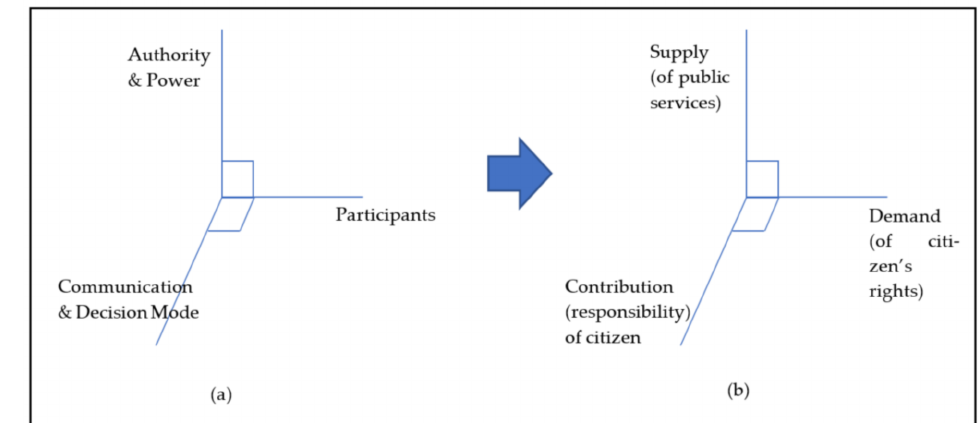
Figure 3. From democracy cube to co-created space. ( a ) Democracy Cube [78]. ( b ) Co-created space (authors).